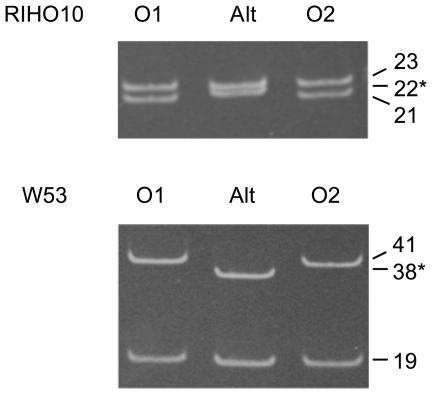
Alterations of repeat regions after 300 generations of serial transfer of strains RIHO10 and W53.PCR products amplified from genomic DNA using primers MC0repf and MC0repr were resolved on acrylamide gels. For each strain the middle lane shows PCR products from the clone with an altered allele (ALT), flanked by two lanes of PCR products from clones which retained alleles of the original lengths. Figures on the right show the numbers of repeats, with altered allele marked by an asterisk. Numbers of repeats were verified by sequencing (see Fig. 5).